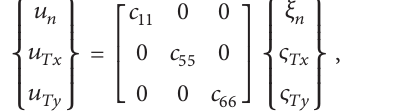
Figure 4: The FEM of the assembled